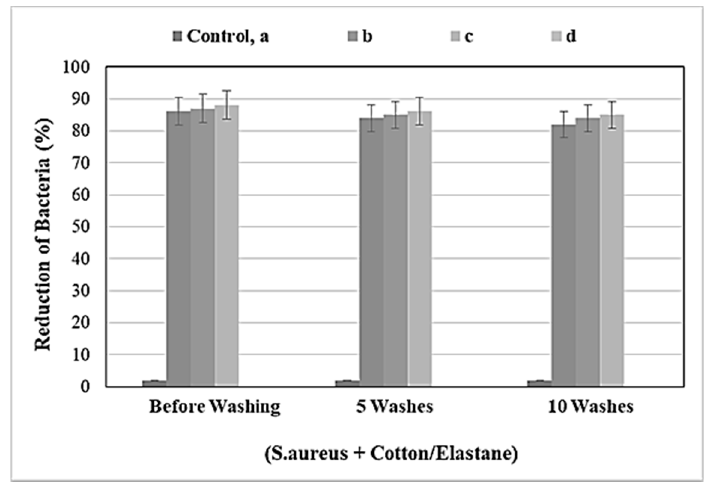
Figure 1. Antibacterial activities using Staphylococcus aureus ( S. Aureus ) ATCC 6538 based on one-way ANOVA ( p < 0.01). a: untreated; b: 10 wt % CaCl 2 ; c: 25 wt % CaCl 2 ; d: 50 wt % CaCl 2 ). The data are represented as mean ± standard deviation (SD).